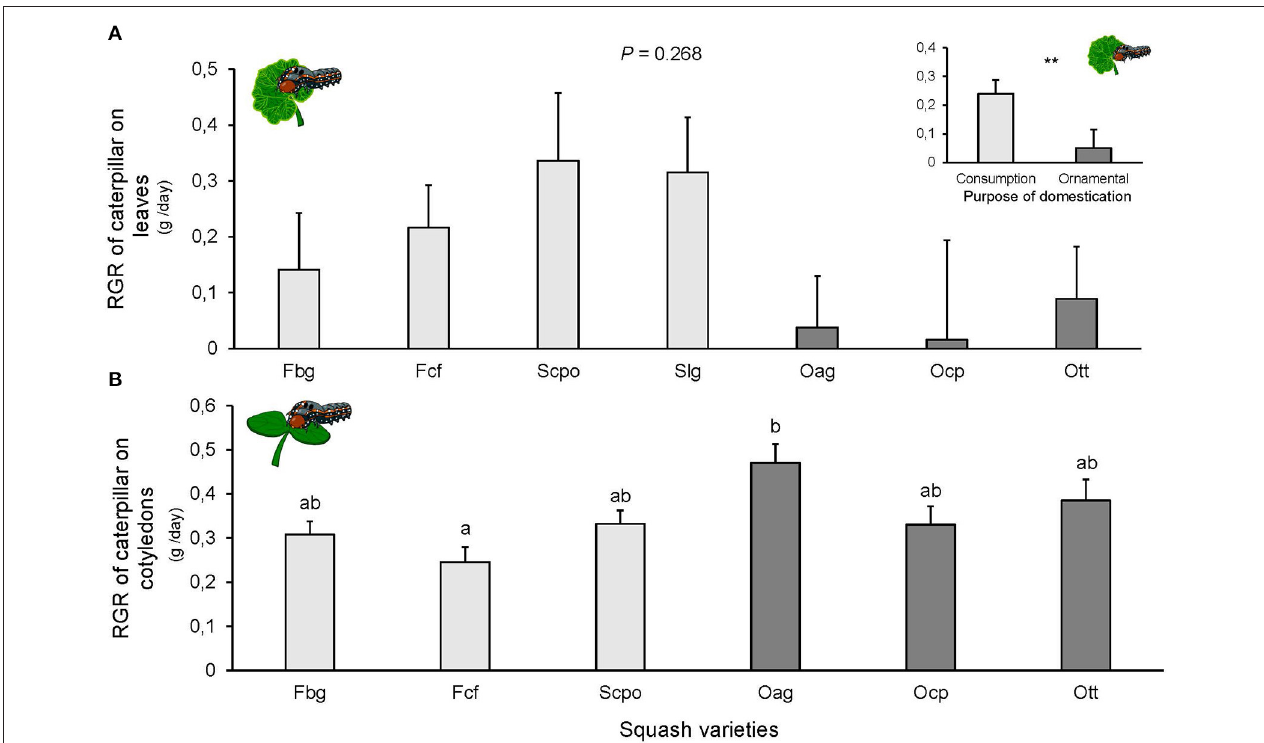
FIGURE 3 | Relative growth rate (RGR) of Spodoptera latifascia caterpillars (A) on leaves ( n = 10) and (B) cotyledons ( n = 10) of squash varieties ( Cucurbita spp.). Bars represent means ( ± SE). Light-colored bars are varieties domesticated for consumption and dark-colored bars are varieties domesticated for an ornamental purpose. RGR was calculated for each individual caterpillar as the weight difference between initial and final weight after 48h of feeding. P -values are given for treatment [linear mixed model], followed by pairwise comparisons of Least Squares Means (LS means). Upper graph is RGR of caterpillars on leaves per purpose of domestication (consumption or ornamental). P -values are given for treatment comparison with glmer model with varieties as random factor. ** P <